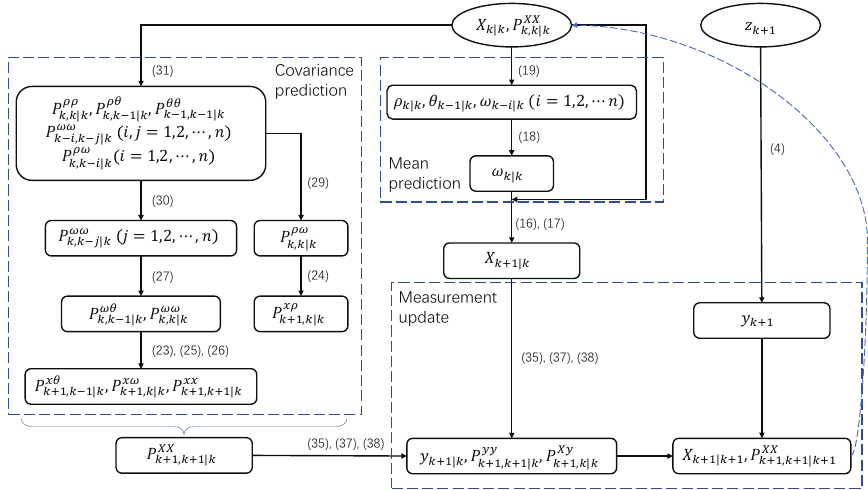
Figure 1. The flowchart of the